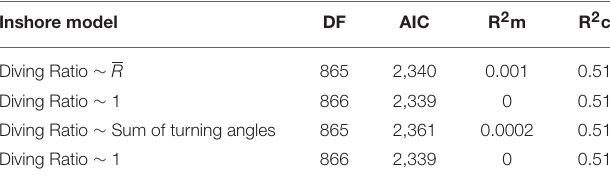
TABLE 2 | Results of generalized linear mixed models testing the relationship between diving ratio and indicators of horizontal path tortuosity. Inshore model DF AIC R 2 m R 2